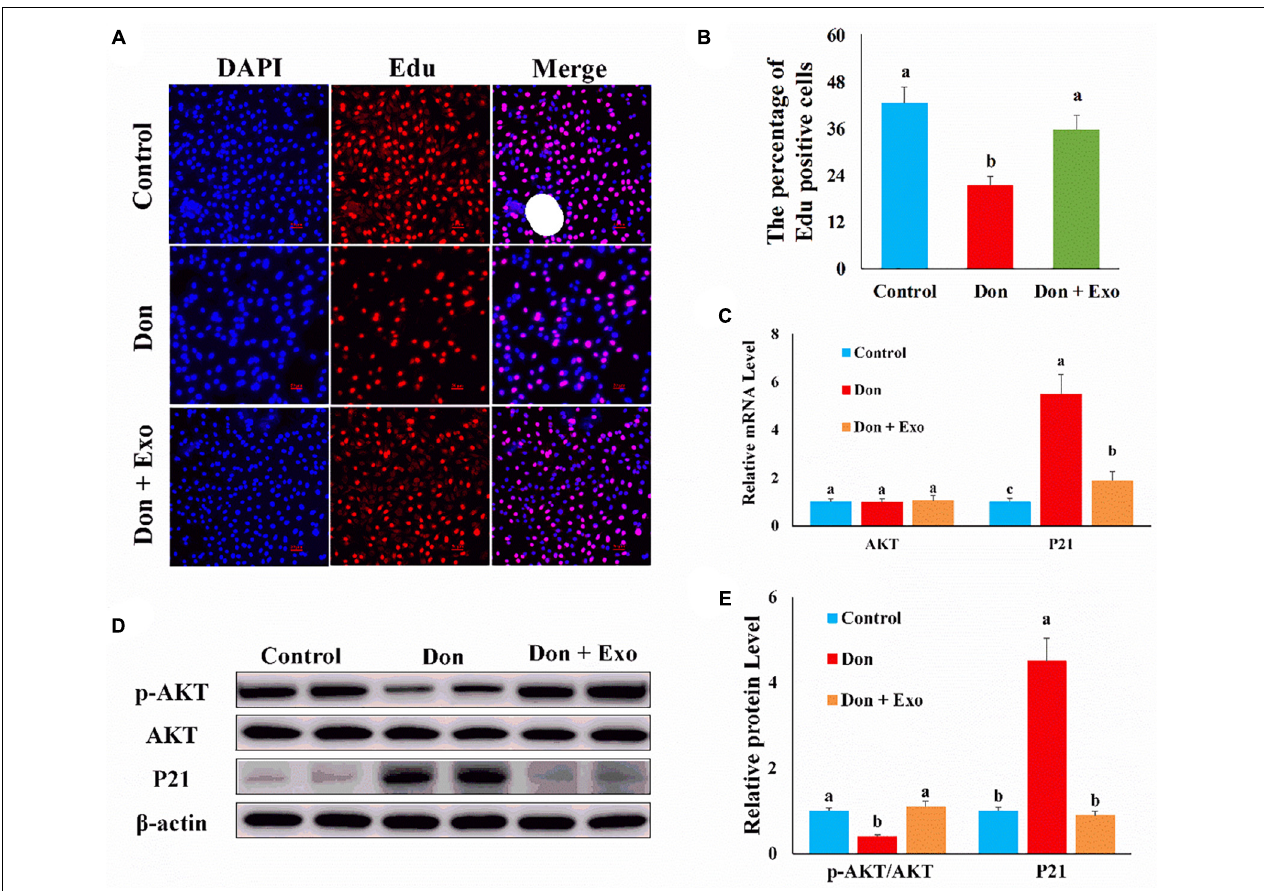
FIGURE 2 | Exosome reversed the inhibitory effect of Don on intestinal epithelial cell proliferation. (A) Representative images of the EdU staining for proliferating intestinal epithelial cells are shown. The cell nucleus was stained with 4 (cid:48) ,6-diamidino-2-phenylindole (DAPI, blue). Proliferating intestinal epithelial cells were labeled with 5-ethynyl-2 (cid:48) -deoxyuridine (EdU) fluorescent dye (red). (B) The quantitative result of (A) . (C) qPCR results indicated that exosome reversed the inhibitory effect of Don on intestinal epithelial cell proliferation. (D) Western blot results showed exosome reversed the inhibitory effect of Don on intestinal epithelial cell proliferation. (E) The relative protein levels obtained by WB band gray scanning. Our results were presented as mean ± SEM of triplicate independent experiments for each group. Bars with different letters indicate they are significantly different ( p < 0.05). In (A) , magnification = × 100; the scale bar on the photomicrographs represents 100 µ m. Don, IPEC-J2 cells were exposed to 1.6 µ g/ml Don for 12 h. Don + Exo, IPEC-J2 cells were incubated with 2 mg/ml exosome for 24 h, then exposed to 1.6 µ g/ml Don for 12